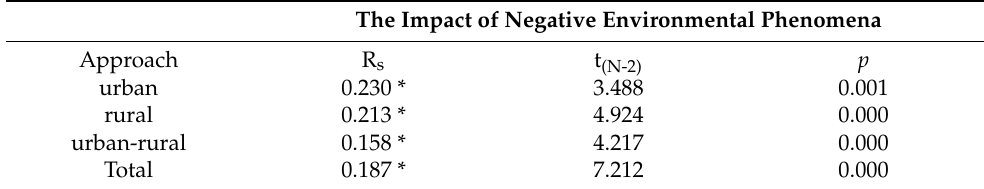
Table 7. Values of R–Spearman correlation coefficients between the impact of negative environmental phenomena and the surface area of green spaces in urban, rural and urban–rural municipalities. The Impact of Negative Environmental